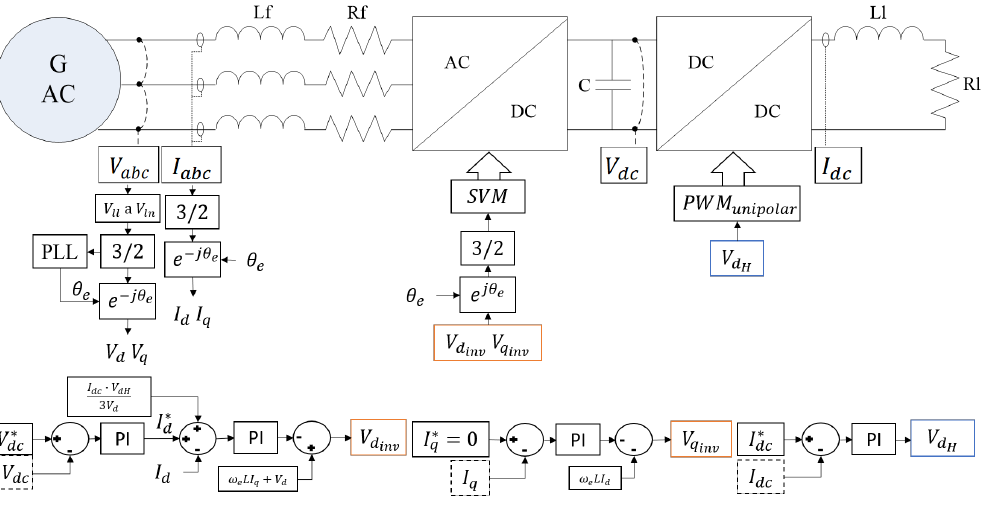
Figure 8. Proposed control